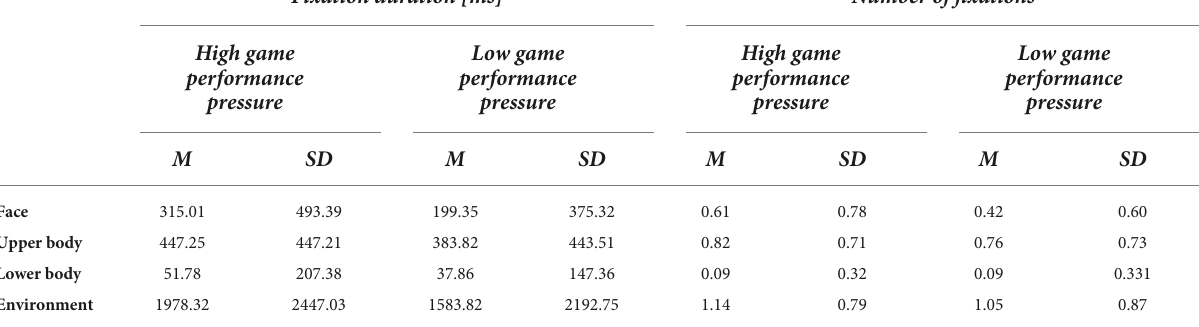
TABLE 1 Means and standard deviation of the fixation durations and numbers of fixations on the AOI face, upper body, lower body, and environment in relation to the game performance pressure condition.